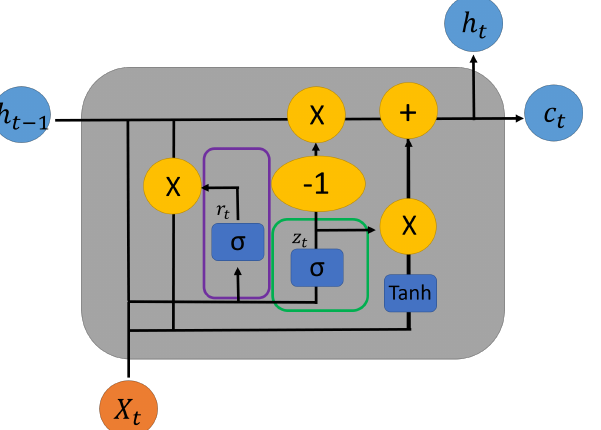
Figure 4. Architecture of a GRU cell with the reset gate circled in purple and the update gate in green.